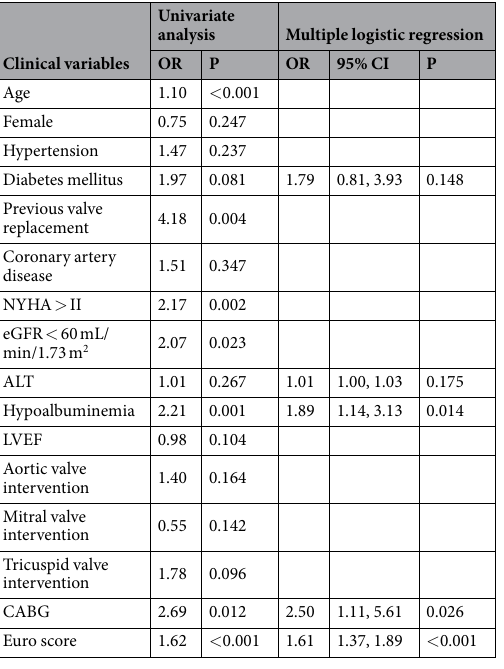
Table 2. Univariate analysis and multiple logistic regression analysis for in-hospital deaths. The variables in the Euro score were not included in the multiple analysis. NYHA, New York Heart Association; eGFR, estimated glomerular filtration rate; ALT, alanine transaminase; SA, serum albumin; LVEF, left ventricular ejection fraction; CABG, coronary artery bypass